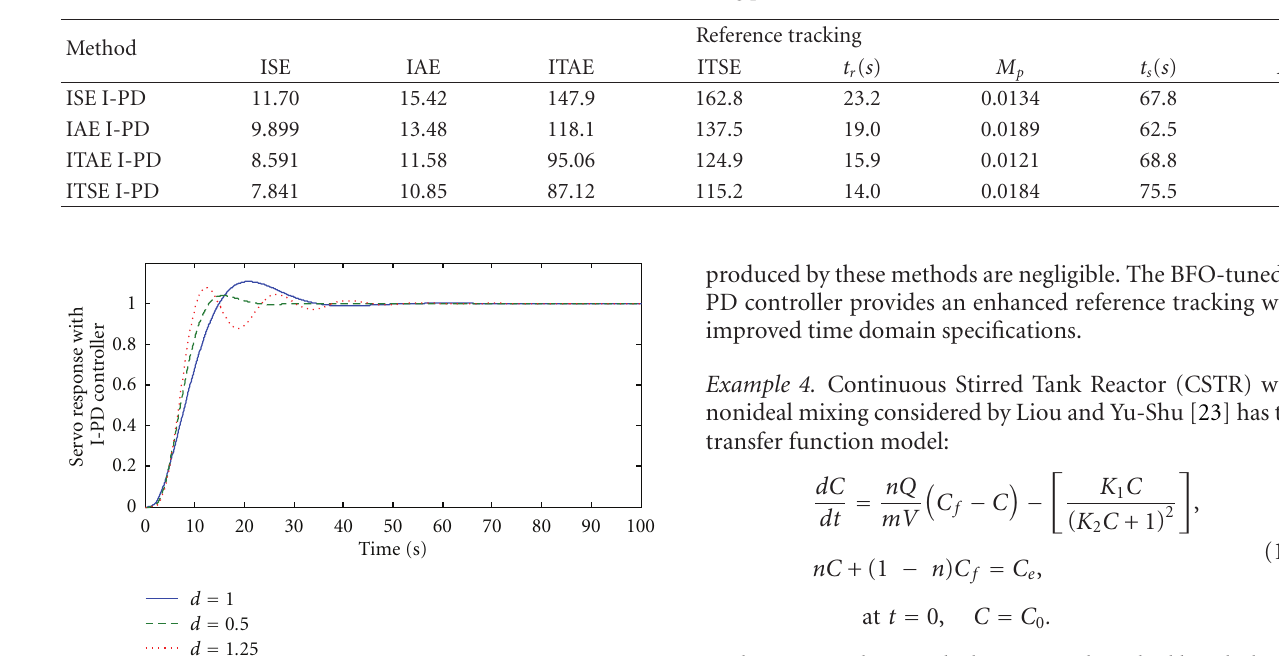
Table 6: Reference tracking performance.